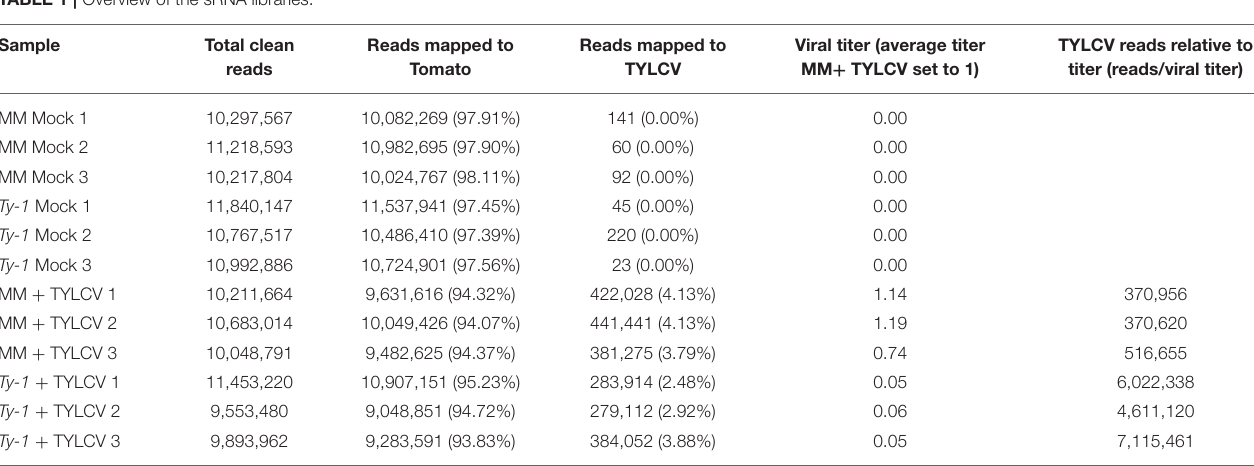
TABLE 1 | Overview of the sRNA